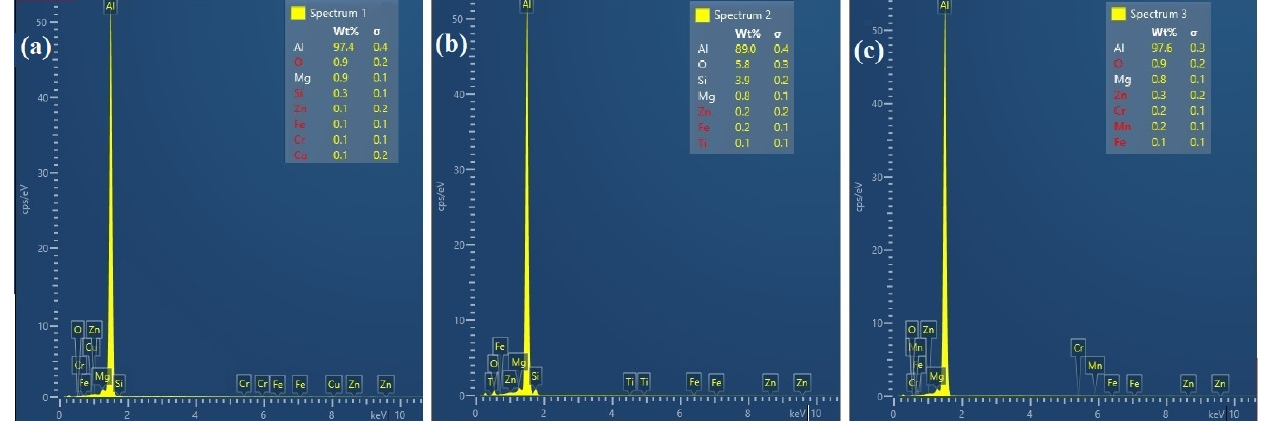
Figure 12. EDS analysis ( a – c ) NZ in upper, middle, and lower layers.